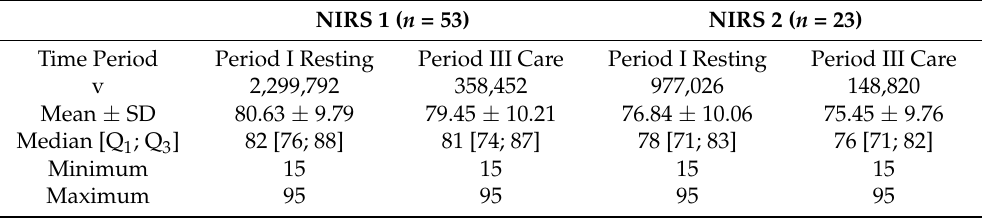
Table 2. Regional cerebral oxygenation saturation (rcSO 2 ) in % during period I (resting time) versus period III (nursing care). v is the number of available values in all infants, SD is standard deviation and Q is